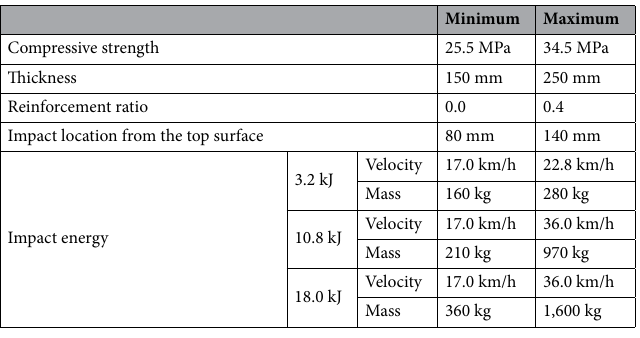
Table 1. The scope of the parametric